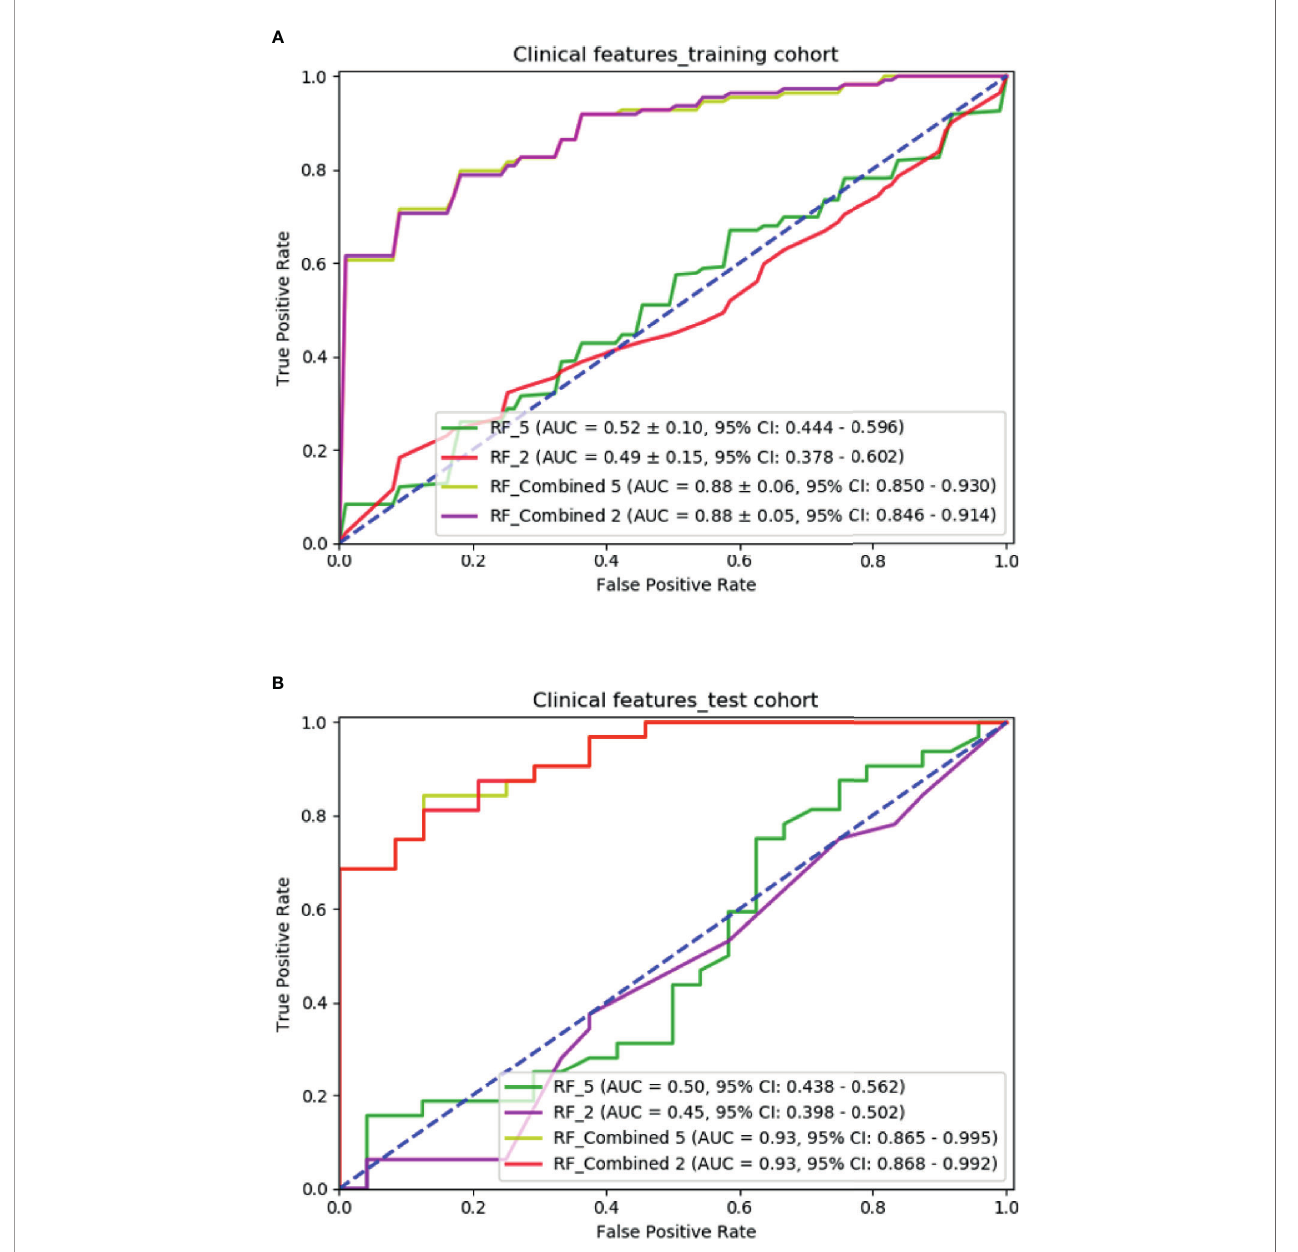
FIGURE 7 | Comparison of predictive models with different clinical features: (A) ROC curves for different models in the training cohort; (B) ROC curves for different models in the independent test cohort. TABLE 4 | Prediction accuracy for different chemotherapy drugs and histological subtypes. Chemotherapy